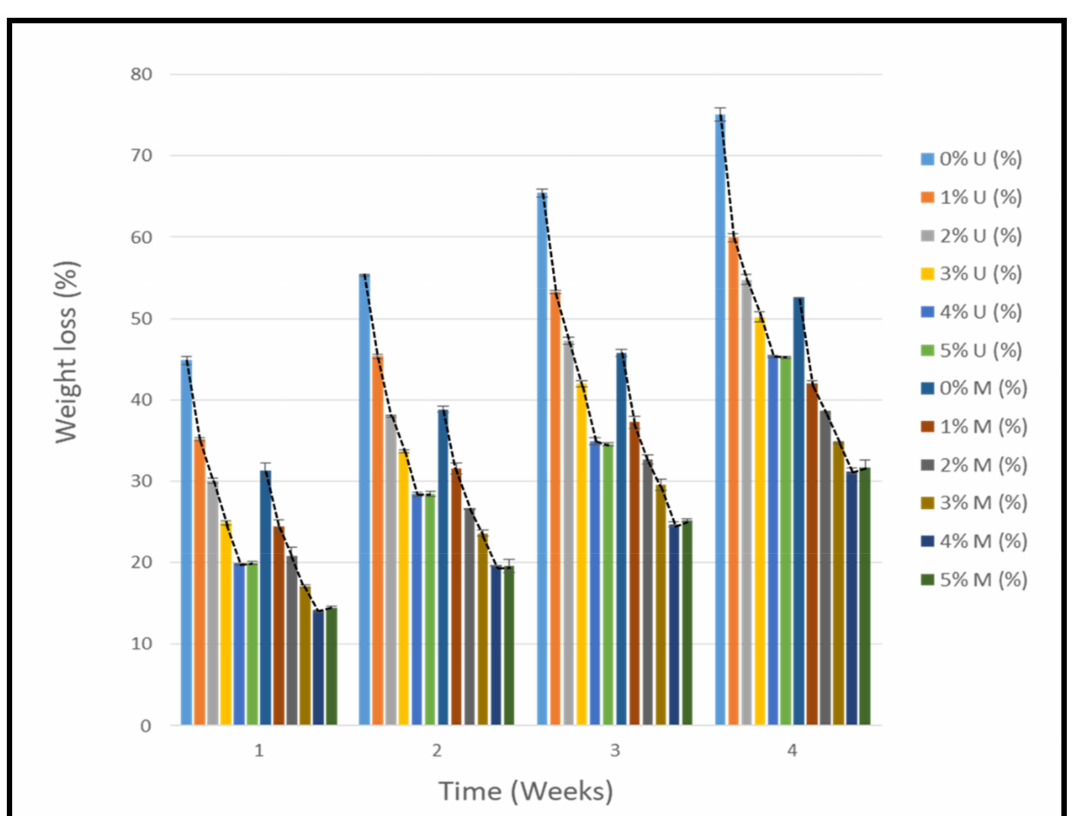
Figure 5. Weight loss (%) of seaweed/CNF composite